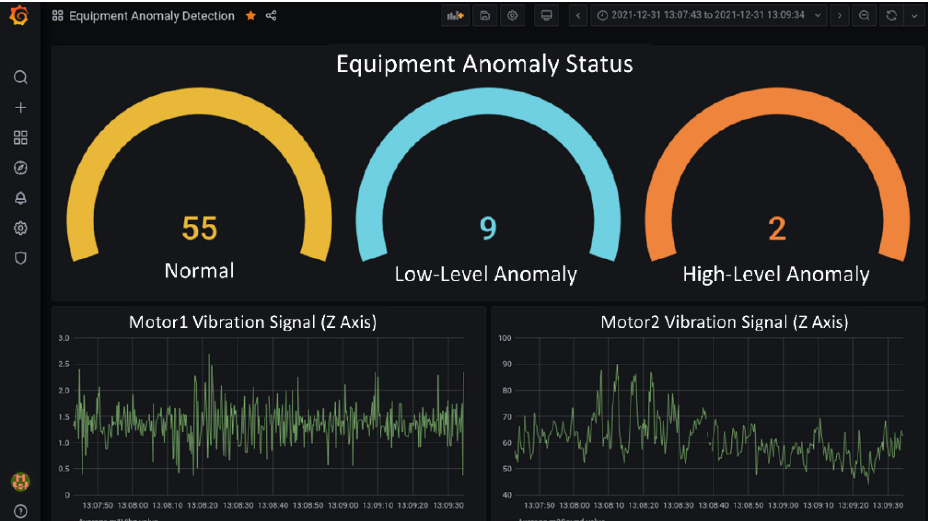
Figure 8. A data analytics dashboard designed to display the collected raw sensor data from robot equipment. The detection results are generated via the system’s DL-based fault detection model.